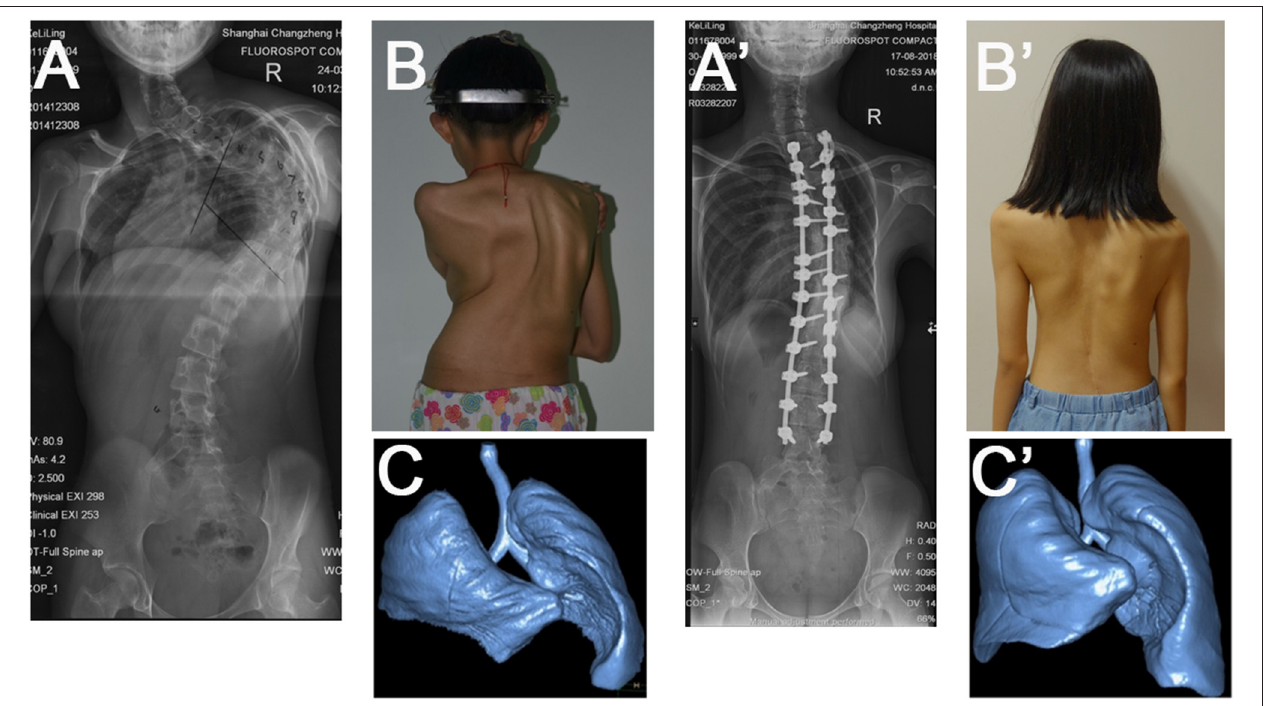
FIGURE 1 | A 20-year-old female with early-onset idiopathic scoliosis. The initial Cobb angle was 112 ◦ (A,B) . Halo gravity traction and posterior correction with instrumentation were performed. At 5-year follow-up, the scoliosis had decreased to 45 ◦ (A’,B’) . Improvement in the lung volumes was noted when compare preoperative reconstructed computed tomographic scan of the lungs (C) with ones at the last follow-up (C’)